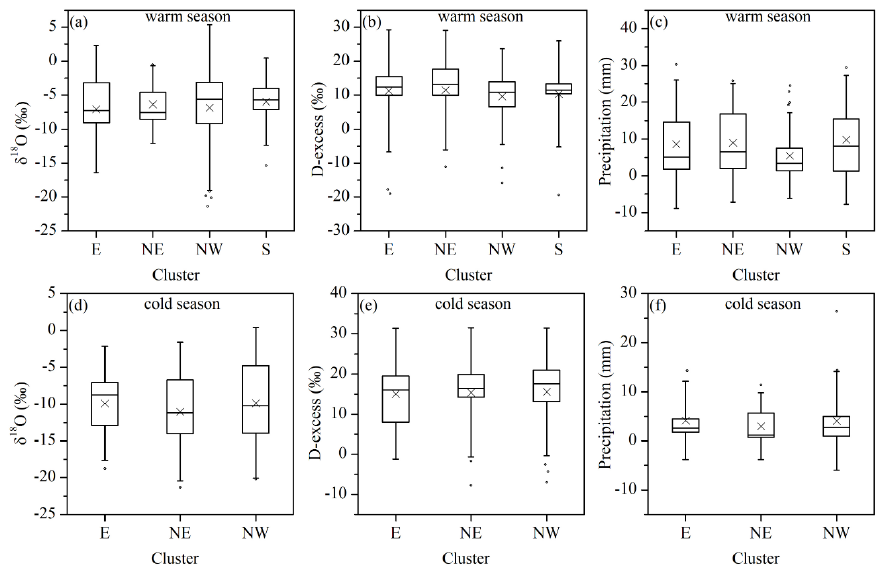
Figure 7. Box line plots of δ 18 O, d-excess , and precipitation for each cluster of water vapor in Minxian Station in the summer half-year ( a – c ) and winter half-year ( d – f ), the top and bottom of the box are the 25th and the 75th percentile, the line near the middle of the box is the median, the intersection is the mean, the black dots are outliers, and the whiskers are the mean plus or minus 2 standard deviations.